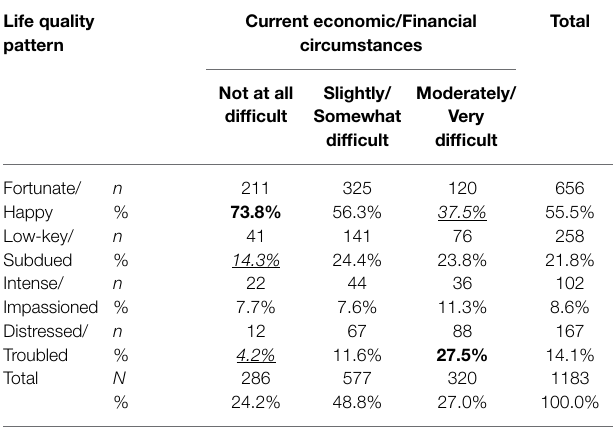
TABLE 6 | Trainees’ current life quality by economic/financial circumstances. 1